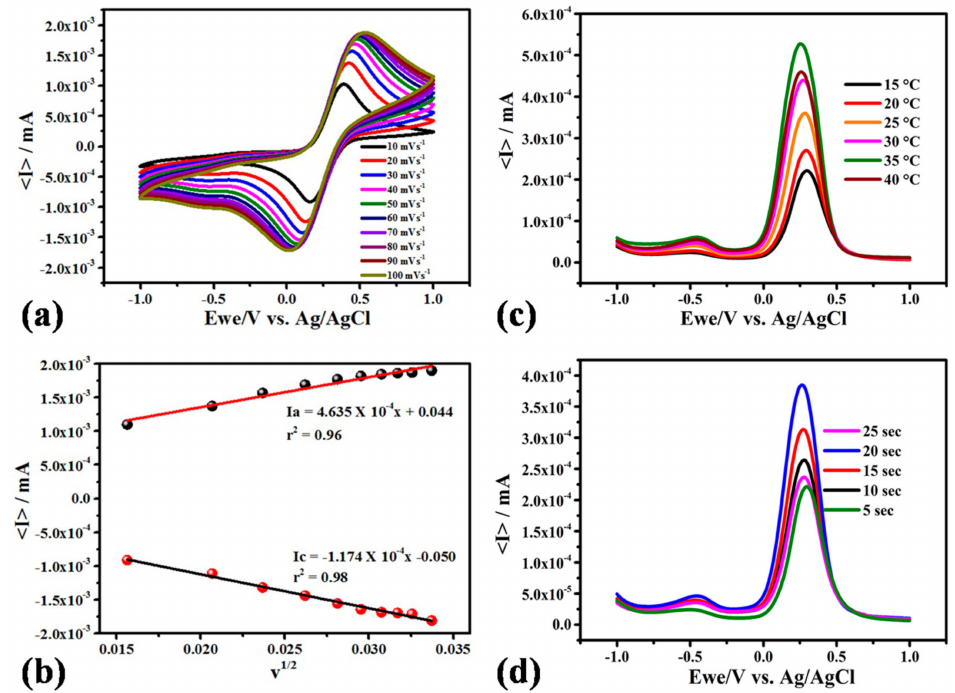
Figure 4. ( a ) Cyclic Voltammogram of probe modified electrode at different scan rates ranging from 10 to 100 mV/s. ( b ) Corresponding peak current vs square root potential ranging from 10 to 100 mVs − 1 . ( c ) Differential pulse voltammogram of probe modified electrode at different temperature ranging from 15 ◦ C–40 ◦ C. ( d ) Differential pulse voltammogram obtained at different response time ranging from 5–25 s. All optimization studies were done using 1 µ M MB (pH 7.4) in 0.1 M